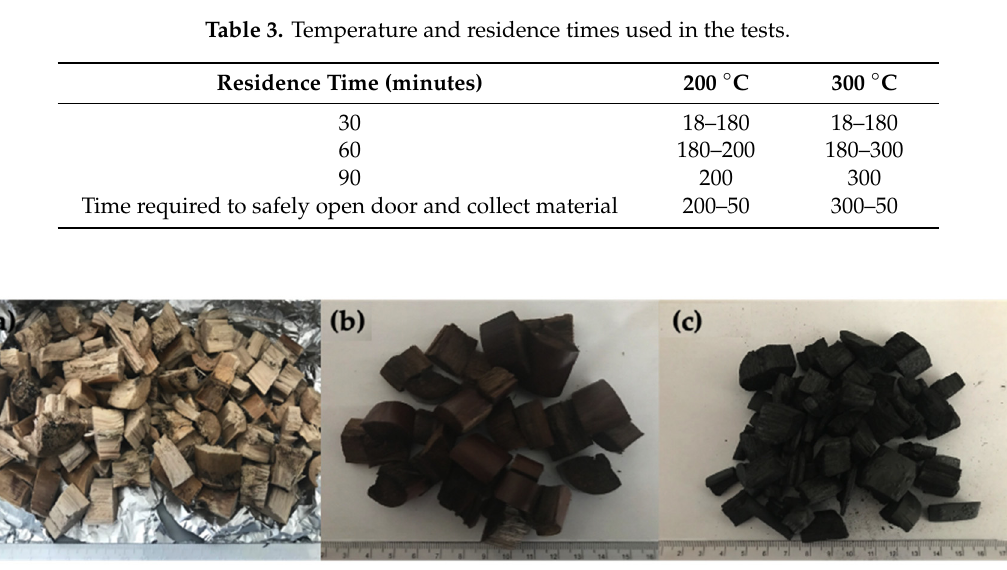
Figure 3. Sugarcane bagasse sample wrapped in aluminum foil.